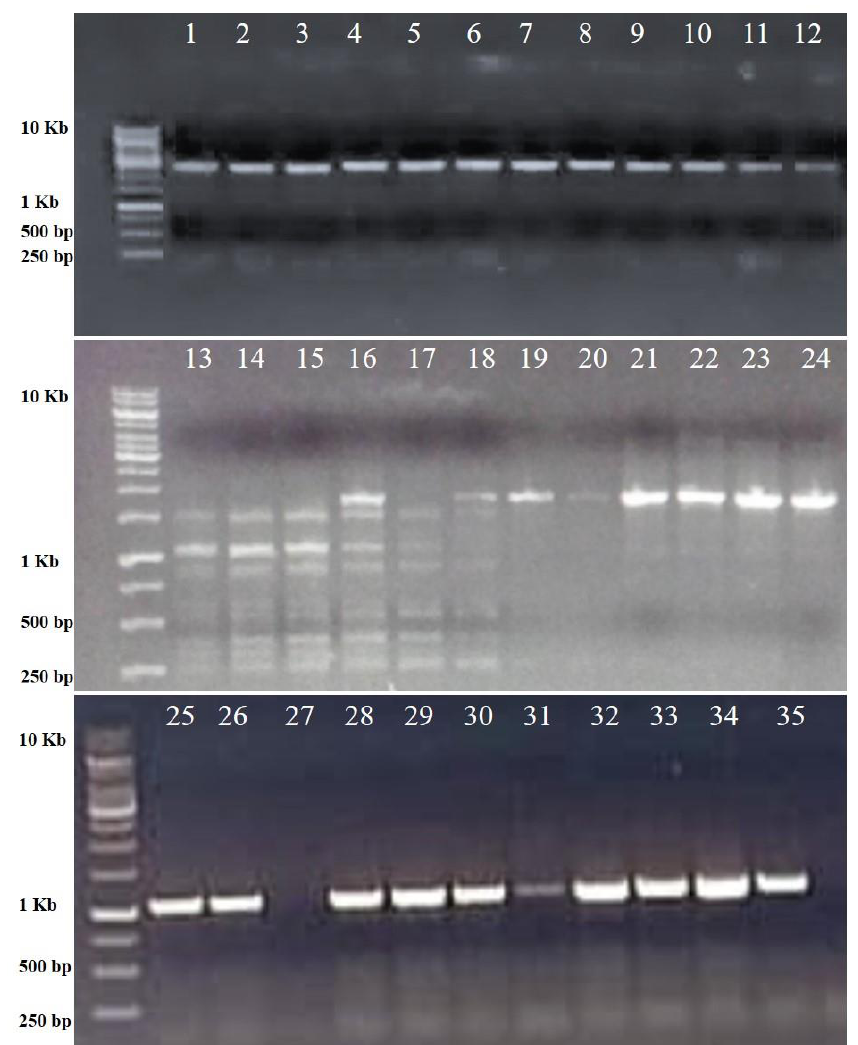
Figure 10. Colony PCR of randomly picked white colonies with gene-specific phyA forward and reverse primers. Out of 200 colonies screened, 35 positive colonies were found to harbor phyA genes (similar sizes but varied intensities). Lane M is the marker DNA of the indicated size, and Lanes 1–35 are thirty-five positive clones.